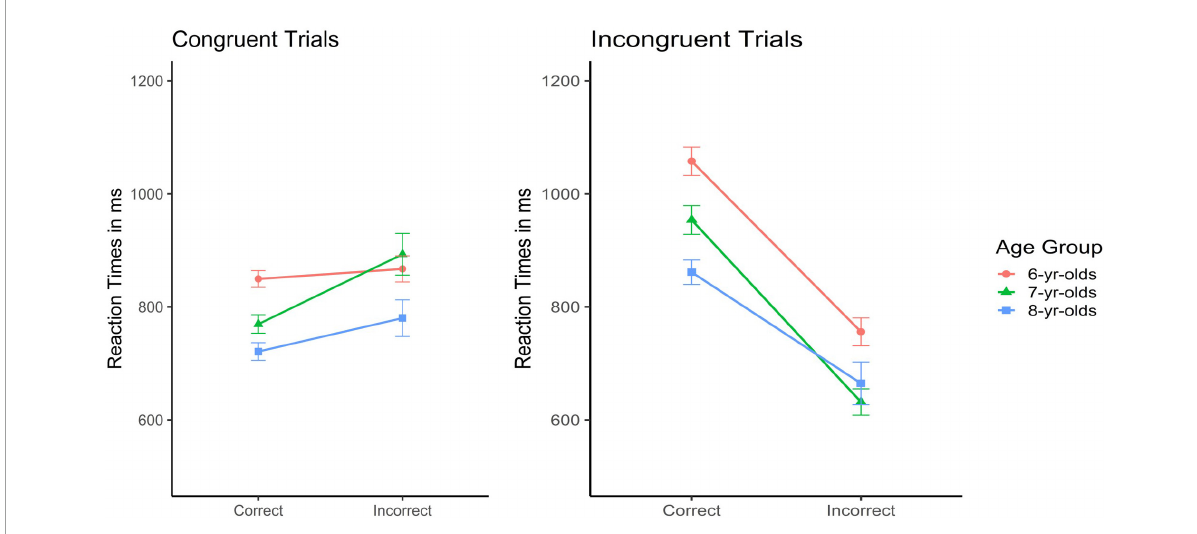
FIGURE4 Mean reaction times in msec for correct and incorrect responses in the Mixed Block as a function of trial type (congruent: left panel; incongruent: right panel) and age group (error bars represent SEM) depicting that only on the incongruent trials, incorrect responses were associated with faster RTs.